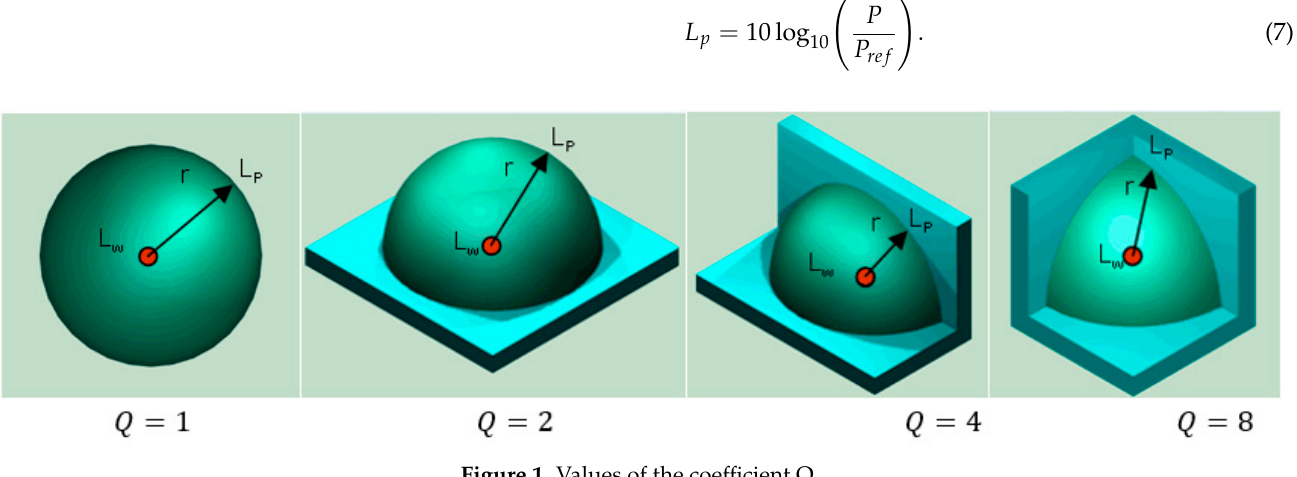
Figure 1. Values of the coefficient Q.